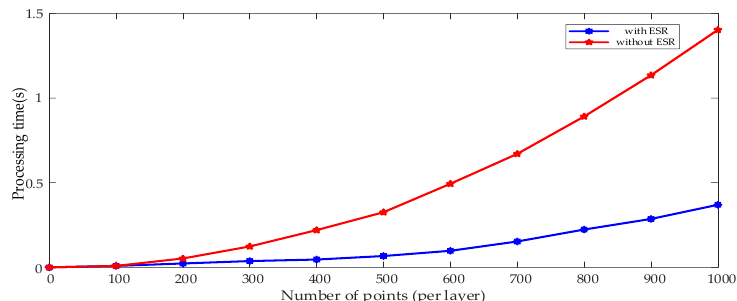
Figure 11. Calculations with respect to the number of points.